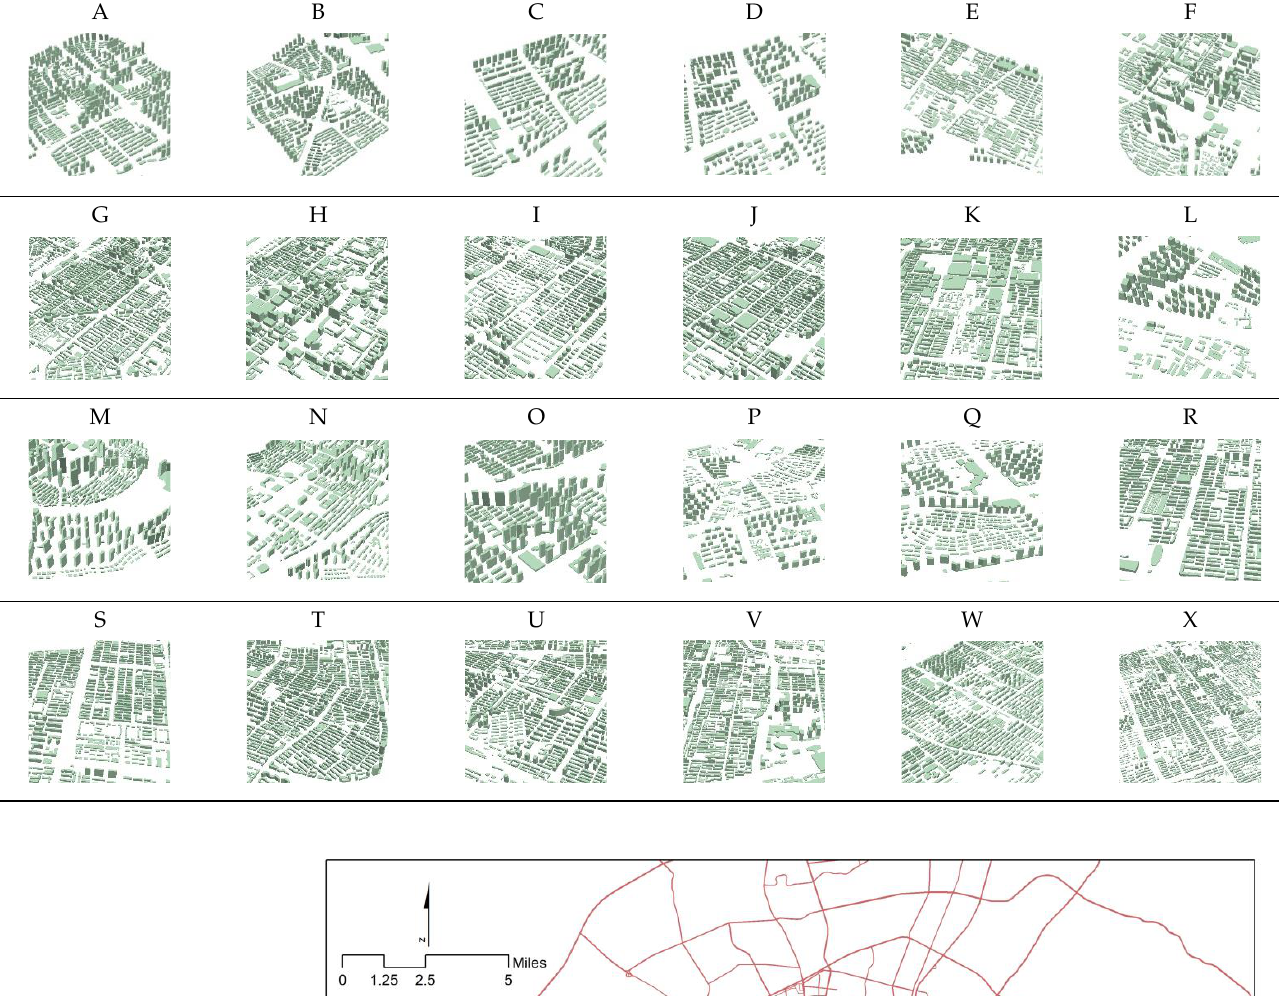
Table 1. Three-dimensional forms of the sub-research areas.